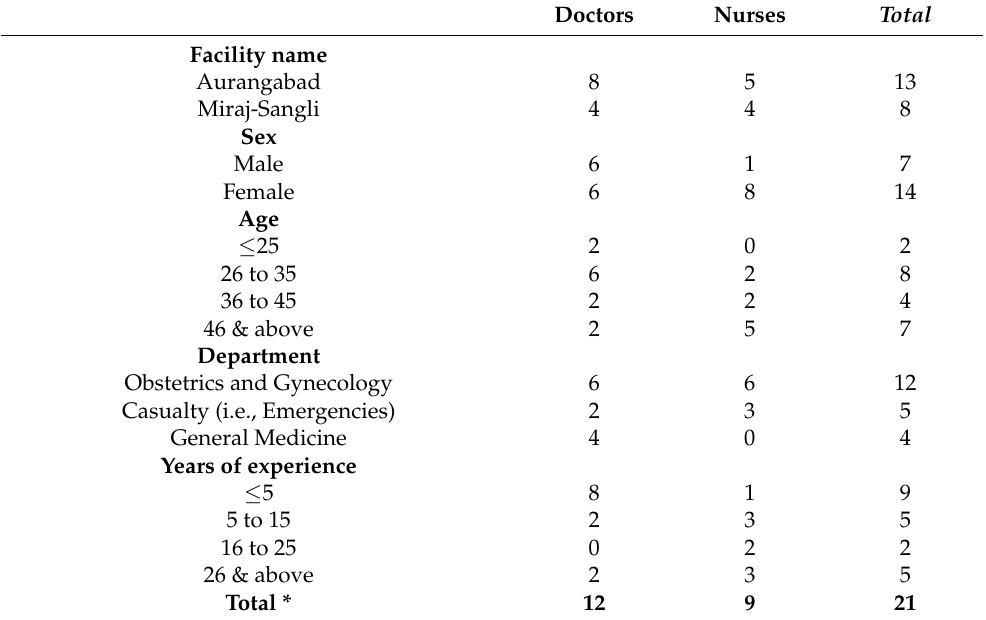
Table 1. Profile of participants for in-depth interviews.